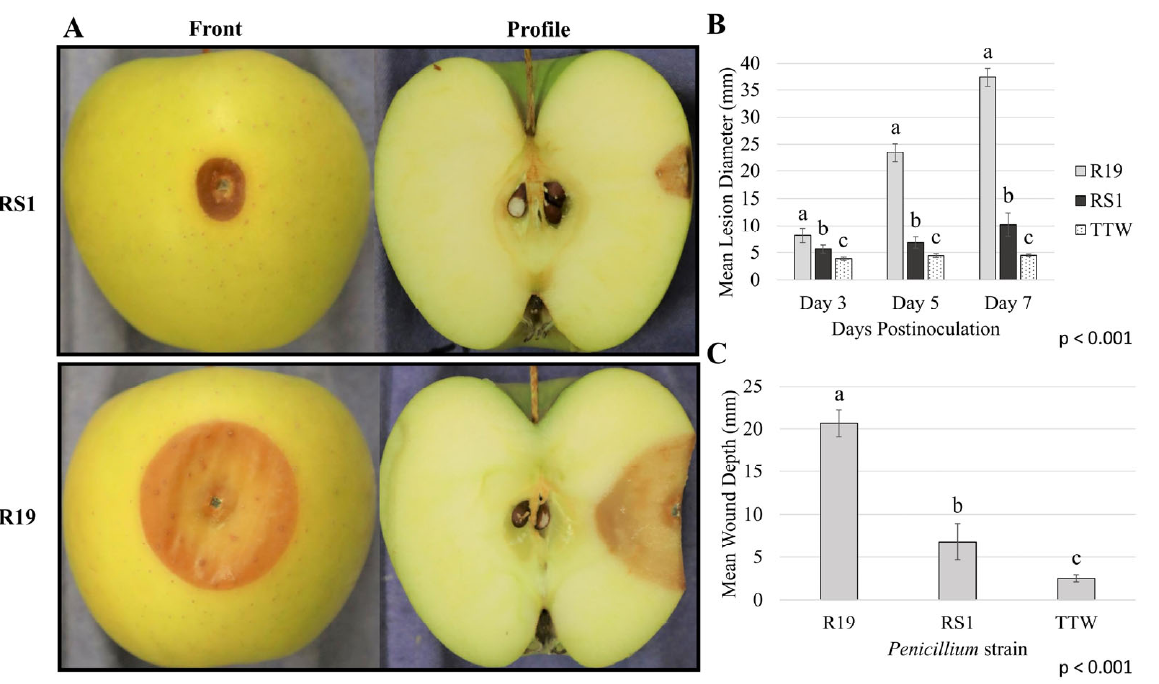
Figure 1. Differences in decay caused by Penicillium expansum (R19) and Penicillium polonicum (RS1) in ‘Golden Delicious’ apple fruit. ( A ) Representative blue mold lesion front (left) and profile (right) of inoculated P. polonicum RS1 (top) or P. expansum R19 (bottom). ( B ) Mean lesion diameters of R19 and RS1 after 3, 5, and 7 days post-inoculation in decayed apple fruit. ( C ) Mean wound depth of R19 and RS1 7 days post-inoculation. For TTW, no decay was observed, and the diameter of the wound was recorded. Error bars represent the standard deviation, with samples from two independent trials. Different letters on the bar graphs denote statistical significance ( p < 0.001), which was determined using a Kruskal–Wallis test and a post hoc pairwise Wilcoxon test with a Benjamini–Hochberg p -value adjustment. TTW = Tween Treated Water (negative control).